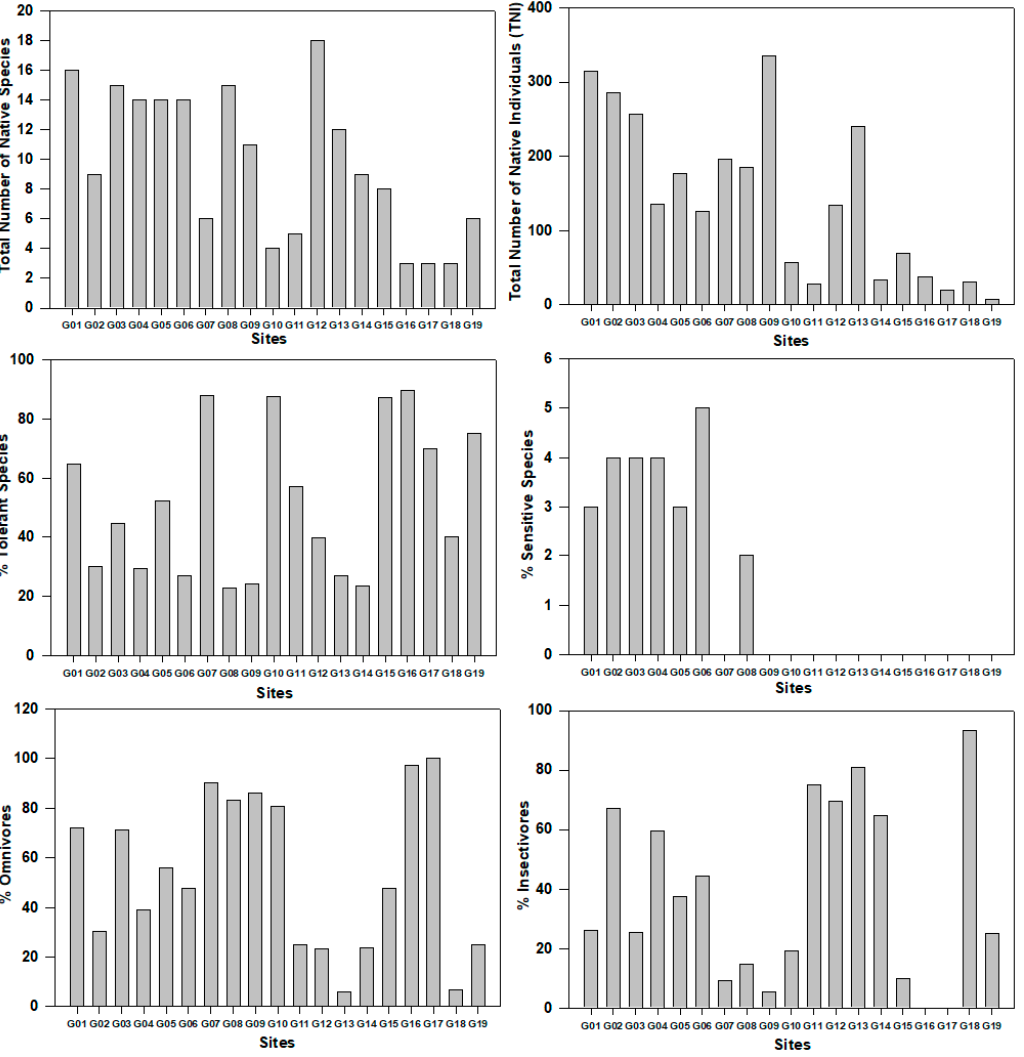
Figure 3. Variation of fish abundance and assemblages according to the sites in the Geum River